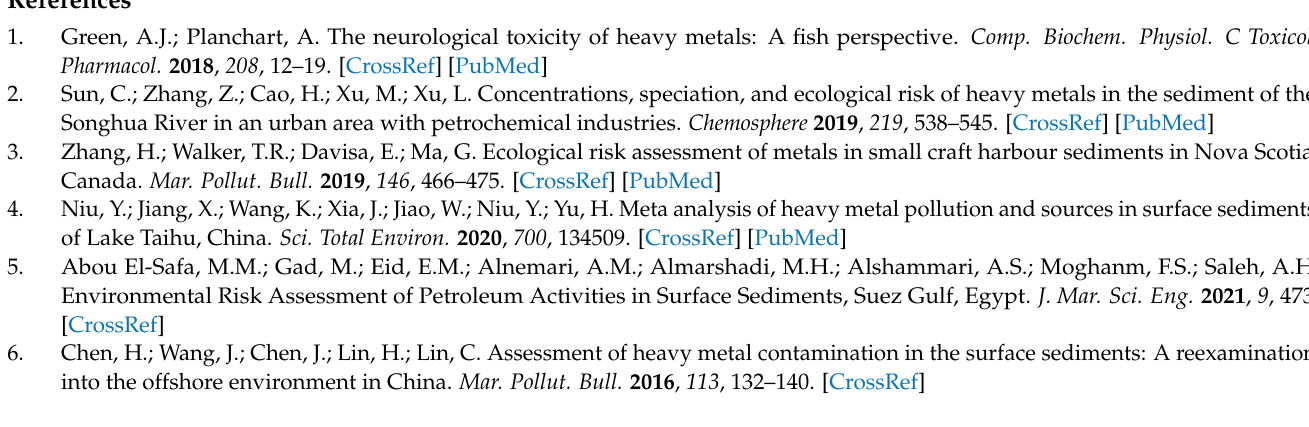
Table S2: Average concentrations of potential toxic elements in sediment samples collected from Gamasa estuary and littoral shelf (2nd